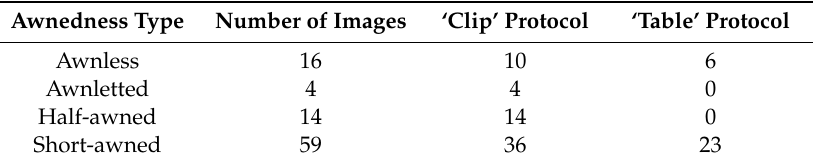
Table 1. Distribution of the spikes in sample according to awnedness